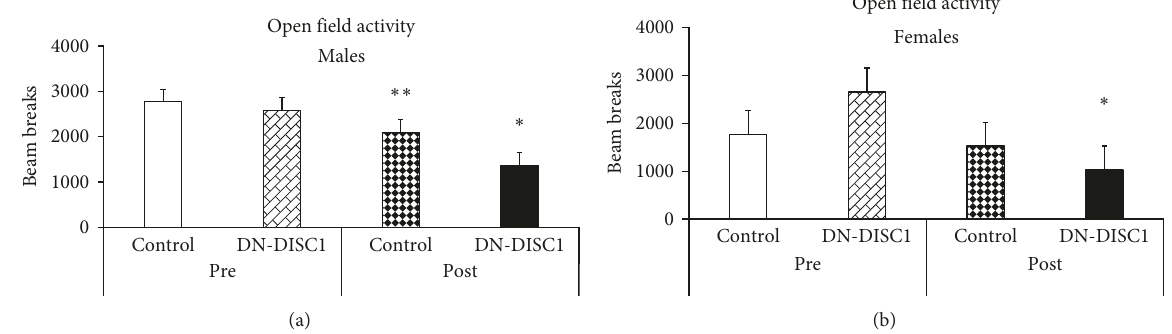
F IGURE 2: Effects of GxE on locomotor activity. Locomotor activity was assayed in open field test for 30 minutes in control and DN-DISC1 male (a) and female (b) mice; n showed a significant effect of infection for male mice, F (1,37) the genotype or the genotype by infection interaction were found for either sex.